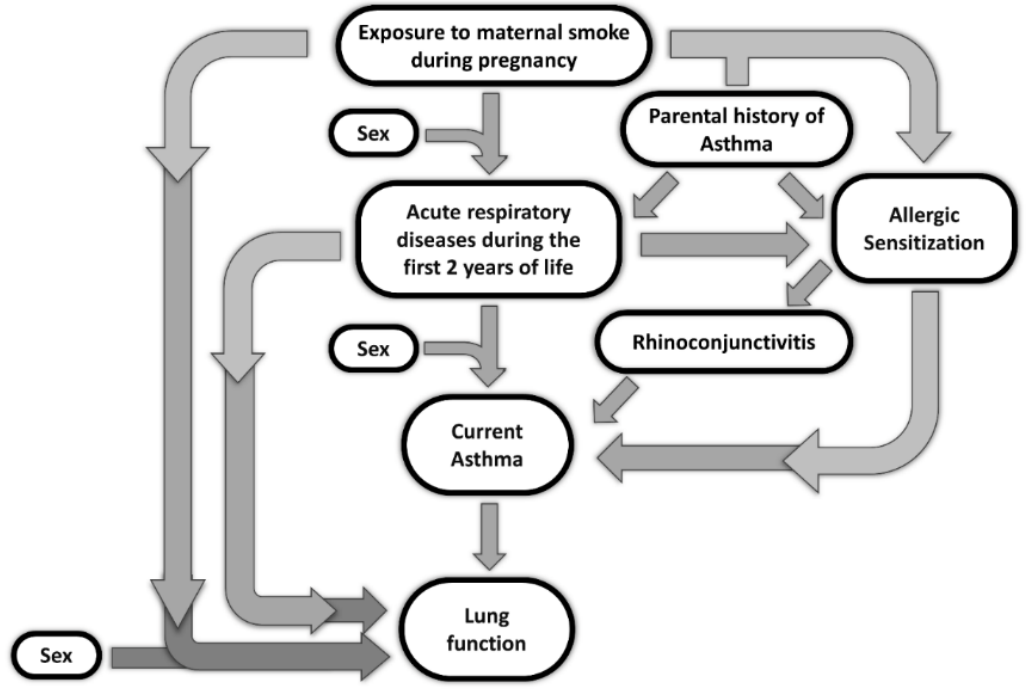
Figure 2. Schematic representation of the complex interactions underlying the development of acute respiratory diseases during the first two years of life and allergic respiratory diseases, as well as conditioning lung function, including both preventable and genetic factors. Supplementary Materials: The following are available online at www.mdpi.com/xxx/s1, Table S1: Multiple linear regression model for FEF 25–75% (z-score), separately for female and male children , Table S2: Multiple linear regression model for FEF 25–75% (z-score) among 1102 “healthy” subjects only, Table S3: Multiple linear regression model for FEF 25–75% /FVC ratio.